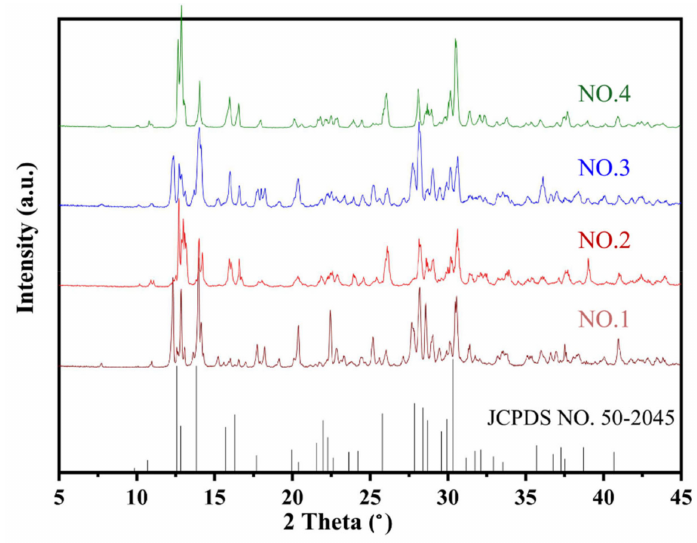
Figure 6. The XRD pattern of four composite particles samples. Purple, red, blue and green lines represent samples of NO.1, NO.2, NO.3 and NO.4,